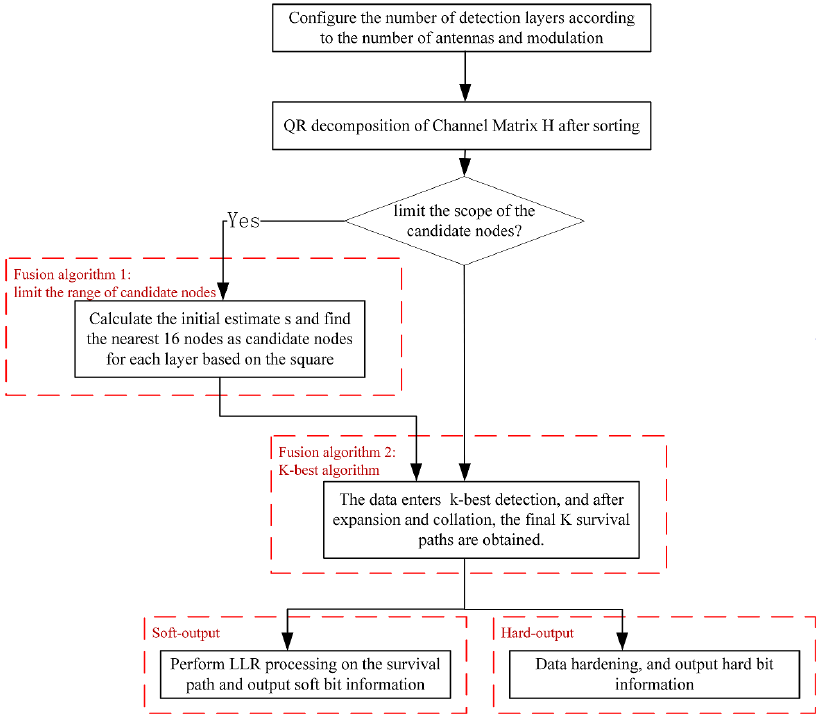
Figure 2. Flow chart of the proposed algorithm in this